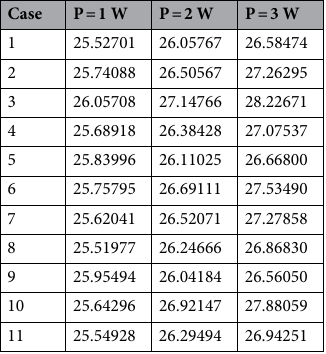
Table 5. Results of final temperature (t = 620 s) for designed